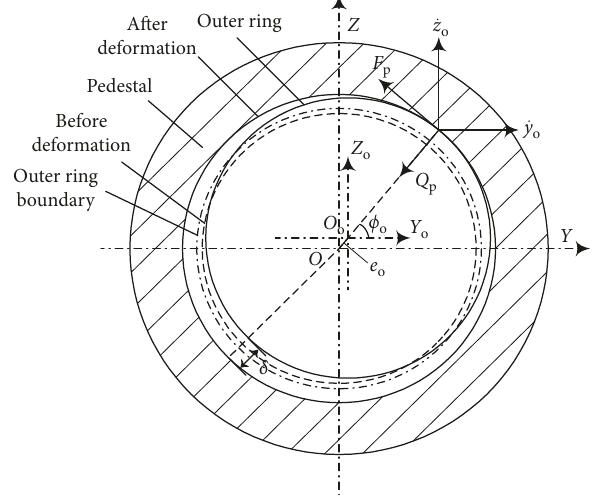
boundaryBefore Outer ring